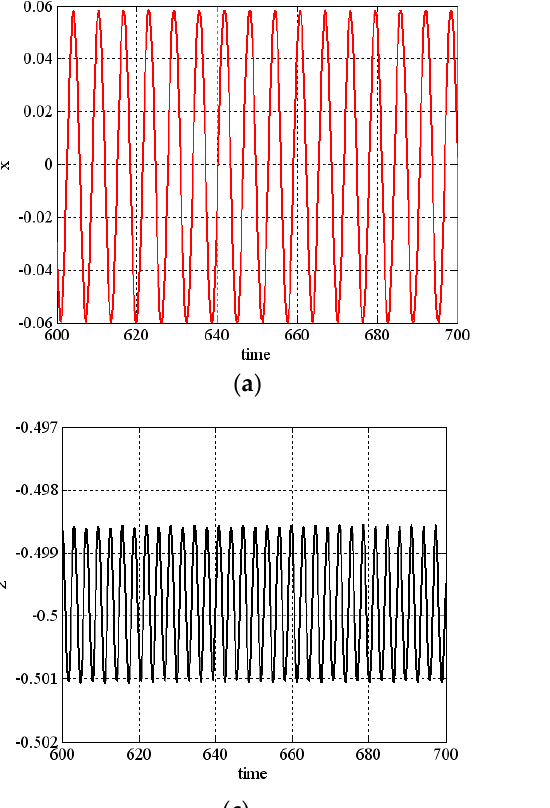
Figure 3. Stable limit cycle for system (1) (for coordinate x ( a ); for coordinate y ( b ), for coordinate z ( c ) and phase space ( d )) when